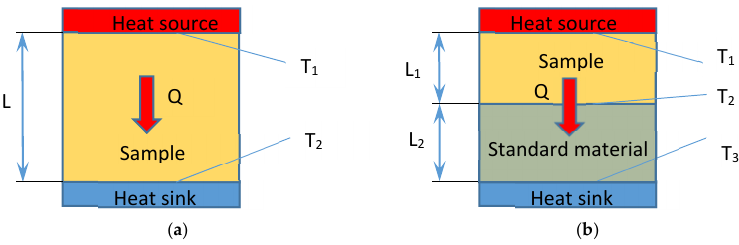
Figure 3. Principles of steady state methods ( a ) Absolute technique; ( b ) Configuration of the comparative cut-bar technique.